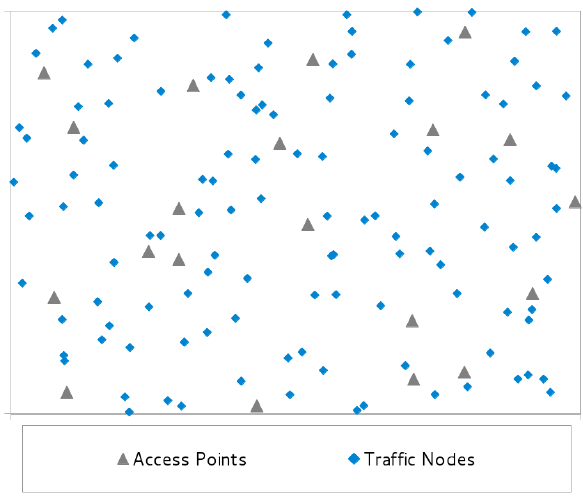
Figure 1. Sample instance topology of a wireless local area